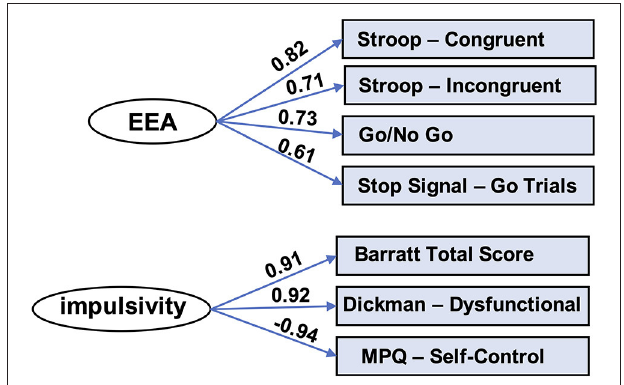
FIGURE 3 | Bifactor model of general intelligence. Bifactor modeling was performed on nine cognitive tasks in the UCLA dataset. The resulting model consisted of a general factor (“g”) and four group factors and exhibited excellent fit with the data. WMS, Wechsler Memory Scale; Repro, Reproduction; WAIS, Wechsler Adult Intelligence Scale; Reason,